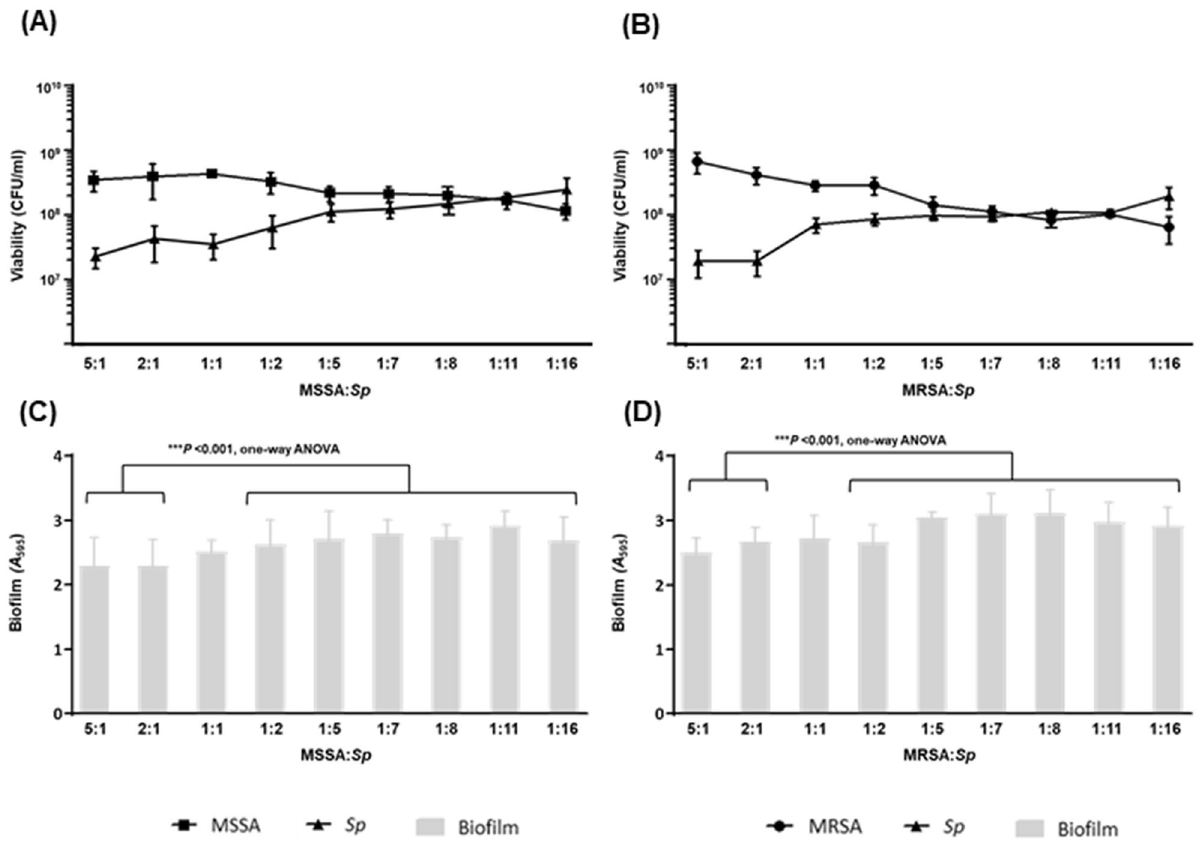
Figure 1. Influence of bacterial proportions in the inoculum on MSSA/MRSA- Sp mixed biofilm formation in vitro. S. pneumoniae and S. aureus were mixed in different proportions, and aliquots of 200 µl final volume containing from 4 × 10 5 to 4 × 10 6 CFU/ml were dispensed into 96-well polystyrene microtiter plates and incubated 5 h at 34 °C. ( A , B ) The viability of MSSA (squares), MRSA (circles) and S. pneumoniae (triangles) was determined by plate counting. ( C , D ) Grey bars indicate mixed biofilm formation determined by CV staining (biomass). Data represent the average of at least three experiments. Standard deviation bars are